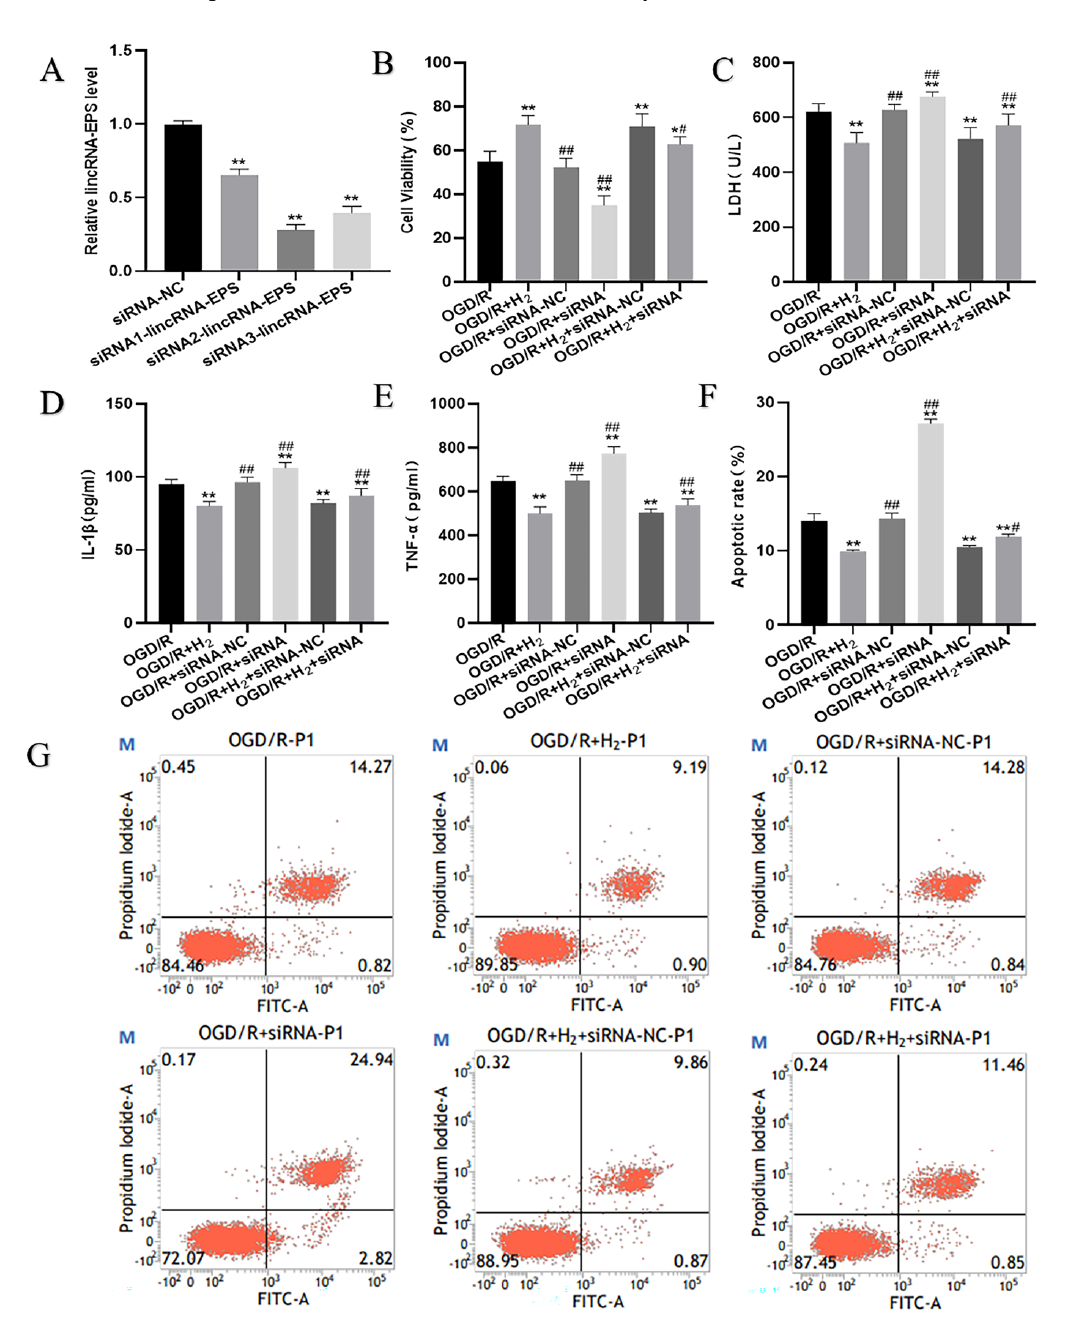
Figure 7. LincRNA-EPS knockdown weakened the protective effects of H 2 . ( A ) The siRNA-lincRNA-EPS efficacy evaluation. The data were displayed in a mean ± SD format. * p < 0.05, ** p < 0.01 vs. siRNA-NC group. ( B ) The cell viability in each group. ( C ) The release of LDH in each group. ( D ) The IL1- β level in the medium. ( E ) The TNF- α level in the medium. ( F ) Quantification of the apoptosis levels by flow cytometry. ( G ) Images of HT22 cell analysis by flow cytometry as represented by dot plots. Data were reported using a mean ± SD format. A minimum of three separate repetitions of the experiments produced similar findings. * p < 0.05, ** p < 0.01 vs. OGD/R group. # p < 0.05, ## p < 0.01 vs. OGD/R+ H 2 group.